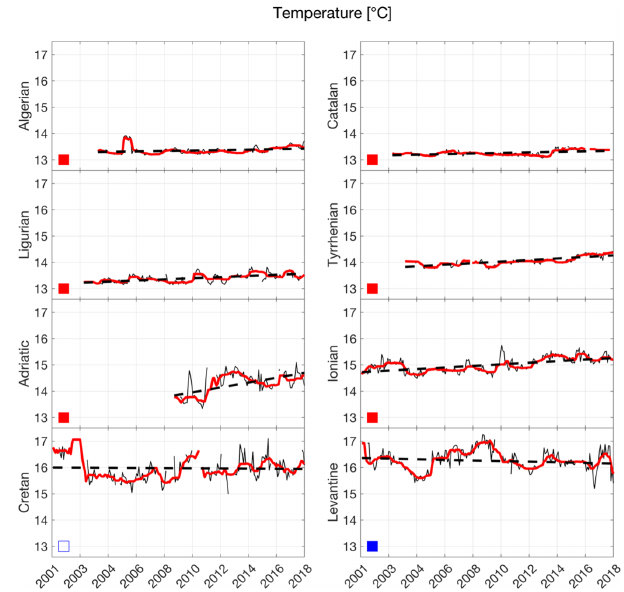
Figure 7. The same as Fig. 3 but for the LIW temperature.